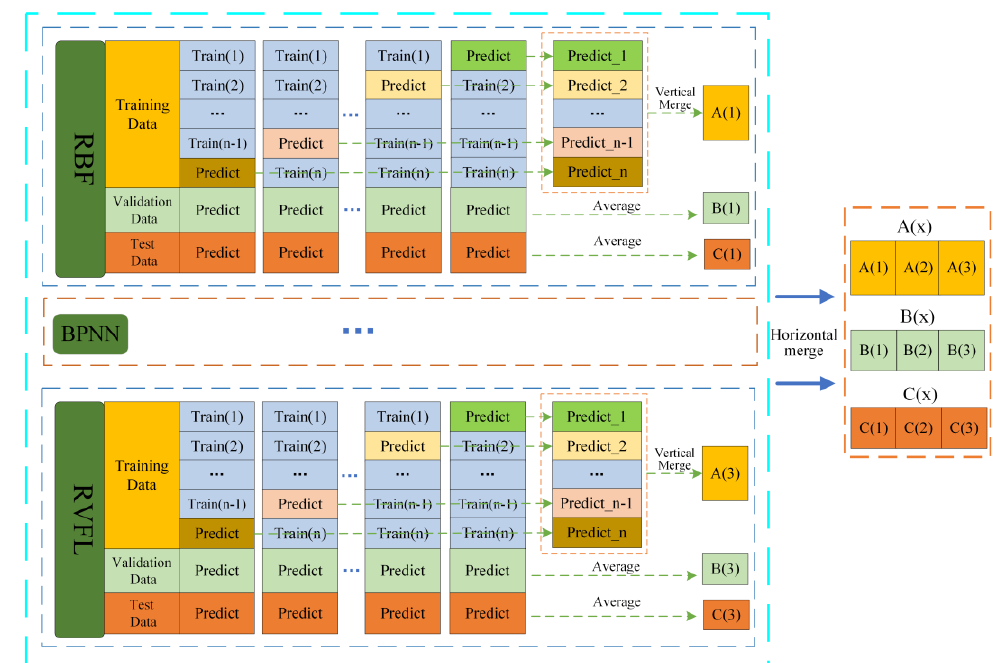
Figure 5. Cross-validation in the training process of the base learners.